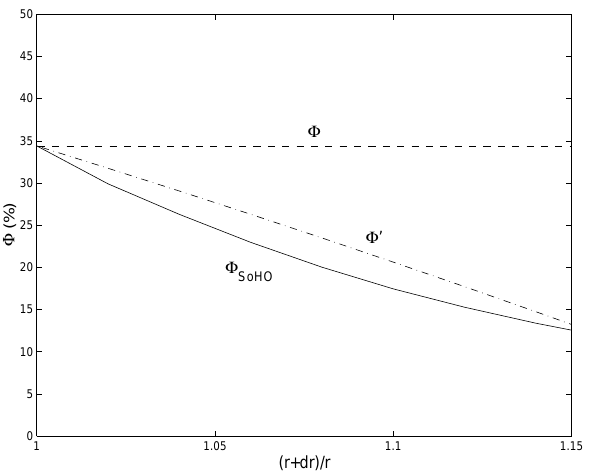
Fig. 3. The mean variation of 8 SOHO with (r + dr)/r for 2 six month periods at solar minimum and solar maximum (solid lines). The variations of plus and minus one standard deviation from these mean values is represented by the dash-dot and dashed lines (for sunspot maximum and sunspot minimum,